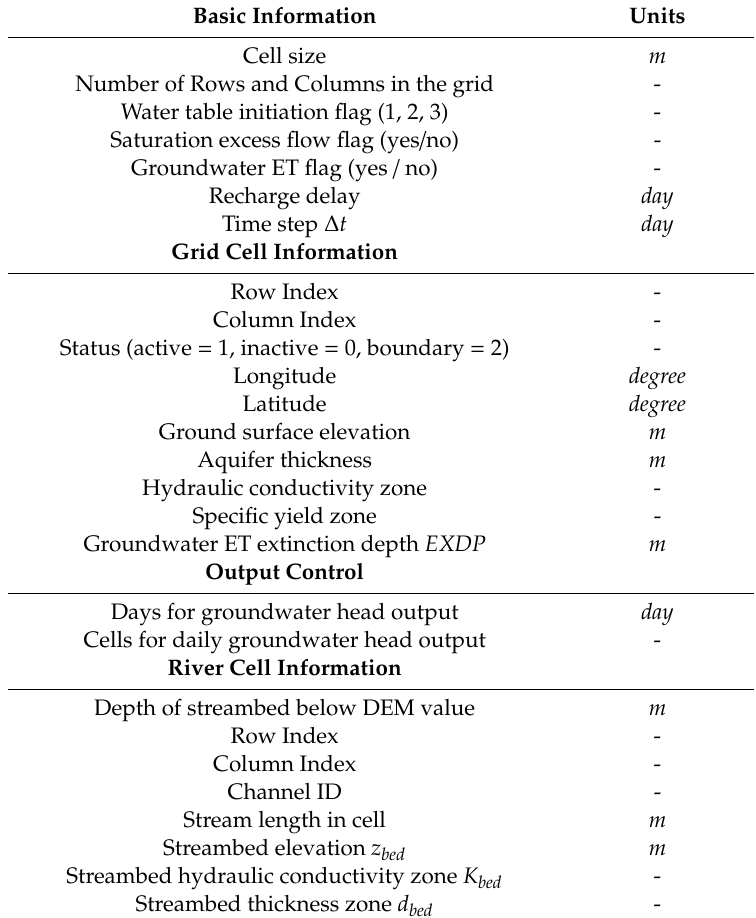
Table 2. Information required in the gwflow.aqu file for the gwflow module. Many of the parameters can be found from national or global datasets, as described in the model application in Section